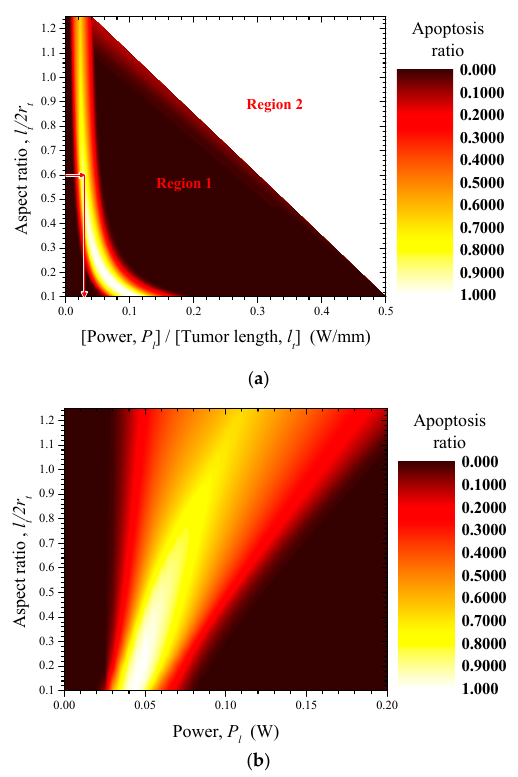
Figure 7. ( a ) The apoptosis ratios ( θ A ) of tumors according to the aspect ratios of the tumors ( l t /2 r t ) and laser power per unit tumor length ( P l / l t ) (radius ratio: 1.00); ( b ) The apoptosis ratios ( θ A ) of tumors according to the aspect ratios of the tumors ( l t /2 r t ) and laser power ( P l ) (radius ratio: